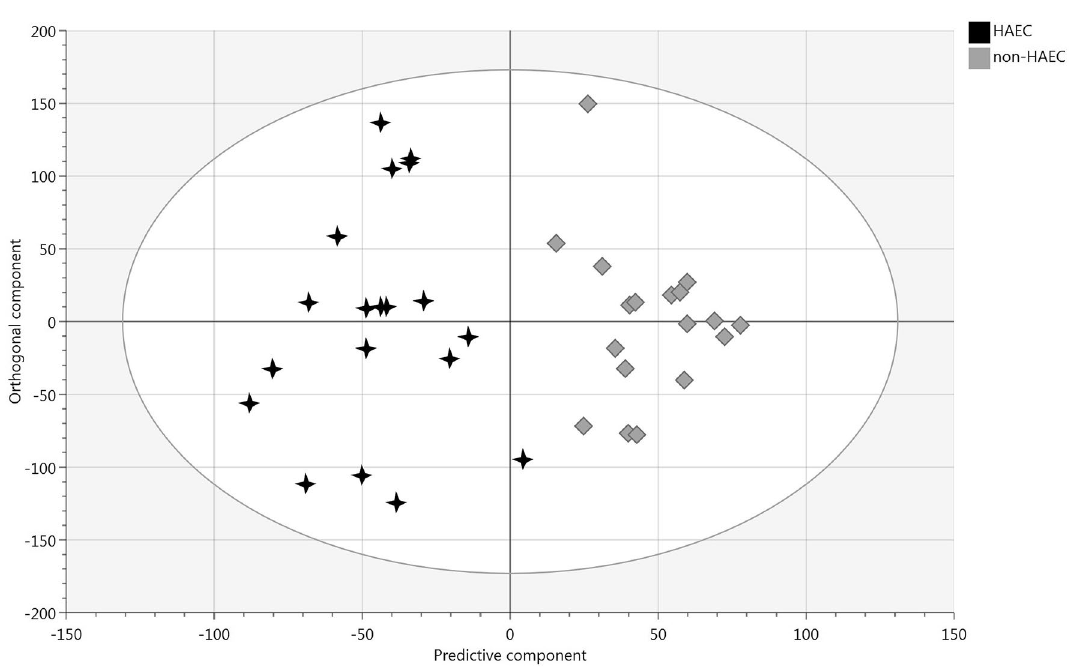
Figure 5. OPLS-DA scatter plot showing separation between patients with (n = 19) and without history of HAEC (n = 18). The validity of the model was confirmed (R 2 Y(cum) = 0.844, Q 2 (cum) = 0.55, CV-ANOVA p-value = 2.73e −05 and good permutation